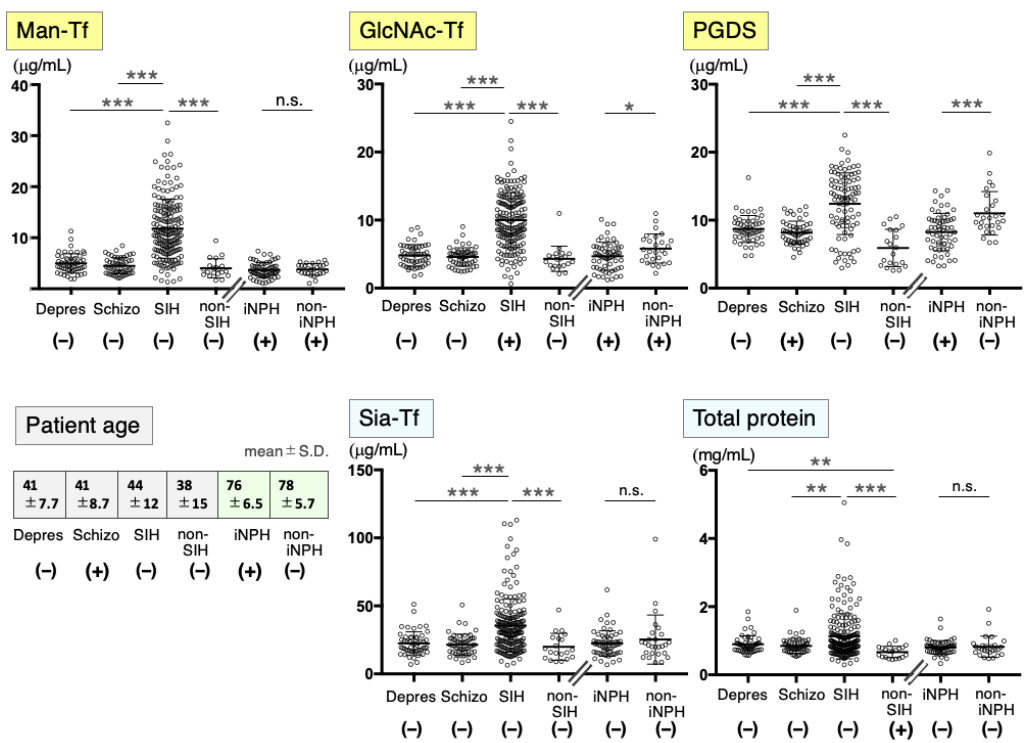
Figure 1. CSF marker levels in neurological diseases. CSF marker levels were analyzed in depression, schizophrenia, SIH, non-SIH, iNPH, and non-iNPH patients. Tf isoforms such as Man-Tf, GlcNAc-Tf, and Sia-Tf were quantified by a lectin/antibody-sandwich ELISA; the glycan-specific probes used were rBC2L-A, rPVL, SSA lectin, respectively. L-PGDS levels were quantified with a sandwich ELISA kit. Total protein was quantified by the micro-BCA method. Ages of patients in each disease are listed in boxes (mean ± S.D.). Data normality for each marker is indicated with a plus (+) or minus ( − ) sign. Multiple comparisons among depression, schizophrenia, SIH, and non-SIH patients were assessed by the Kruskal–Wallis method, followed by Bonferroni correction. Comparisons of iNPH and non-iNPH were assessed by a Mann–Whitney U test. All combinations of clinical groups were assessed, and combinations showing significant differences are indicated with horizontal bars. Probability values: * p < 0.05, ** p < 0.01, *** p < 0.001. n.s.: not significant.